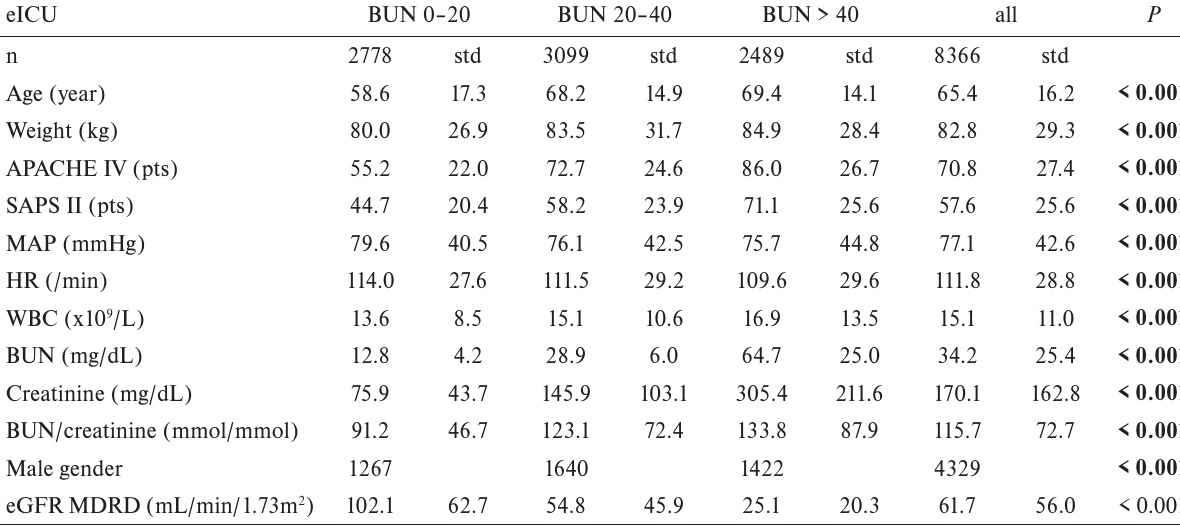
Table 1. Demographics of eICU patients.